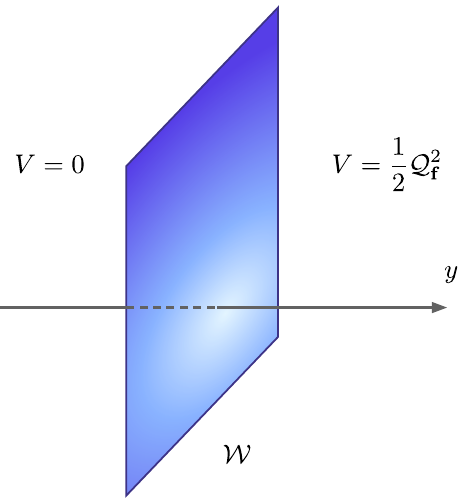
Figure 3 . A generating membrane interpolates between a fluxless configuration and a background with flux f , with a potential V = 1